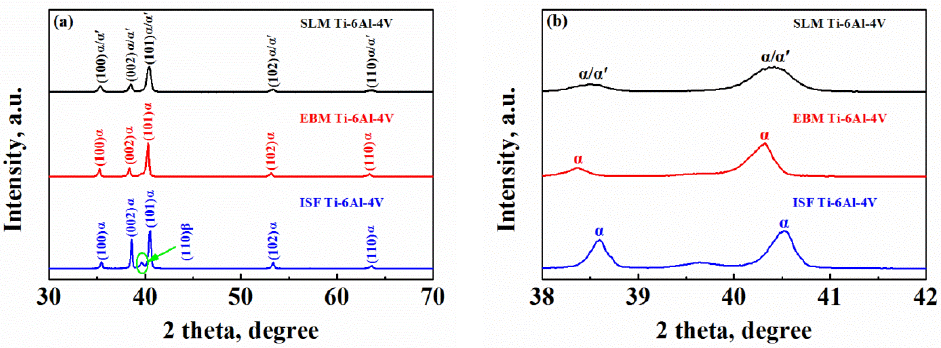
Figure 6. ( a ) XRD patterns of SLM- and EBM-manufactured Ti-6Al-4V and ISF alloy samples, and ( b ) magnified details of the XRD patterns in ( a ) with diffraction angles ranging from 38 to 42°.